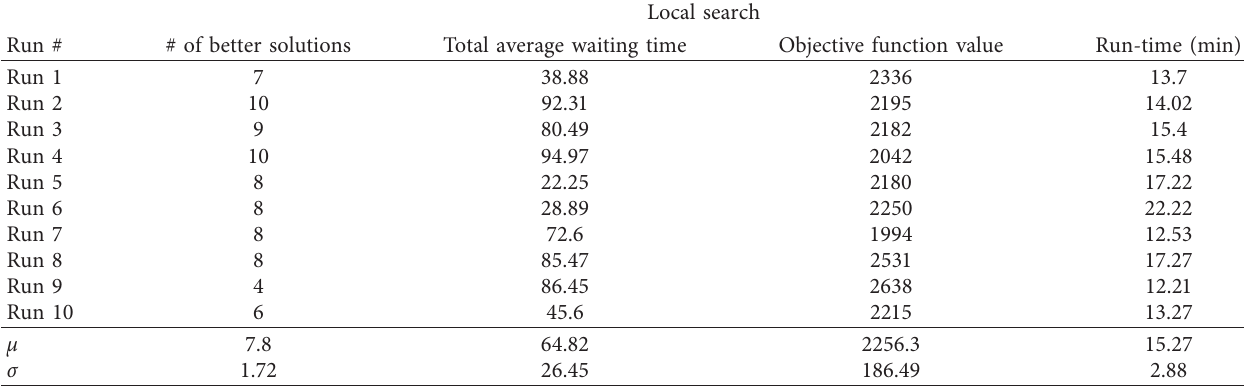
Table 3: Summary of simulated annealing results using local search technique.